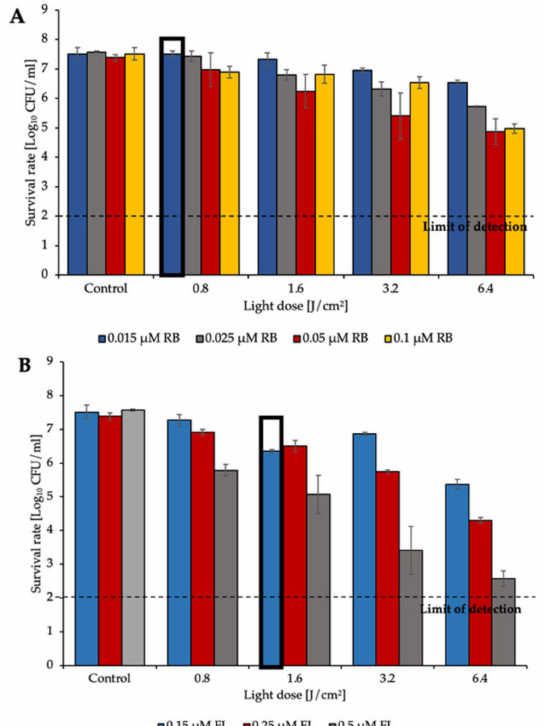
Figure 1. aPDI inactivation of E. faecium with various doses of green light and ( A ) RB concentrations (0.015, 0.025, 0.05, and 0.1 µ M) or ( B ) FL concentrations (0.15, 0.25, and 0.5 µ M). The experiment was performed in three biological replicates. The detection limit was 100 CFU/mL. Bold frames indicate sublethal treatment.